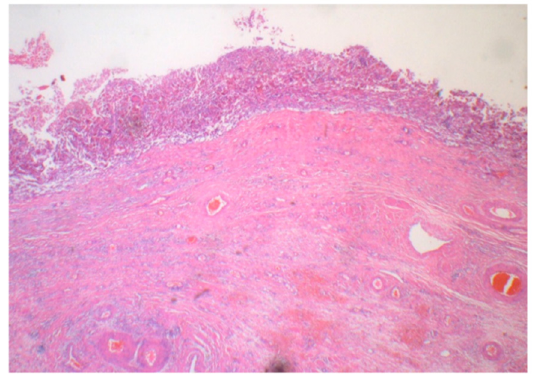
Figure 1. Macroscopic findings: The tumor comprised a small sac (arrow) in a huge cystic legion.